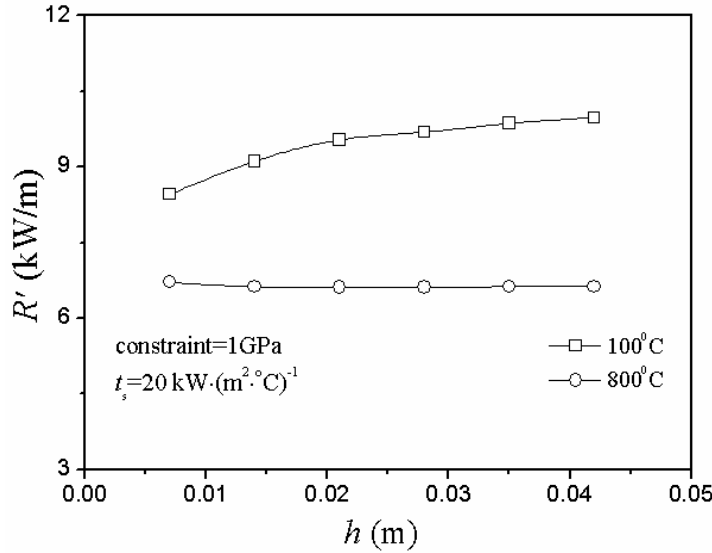
Figure 8. Relationship between the second TSR parameter, R’ , and plate thickness, h , under different initial thermal shock temperature of temperature elevated